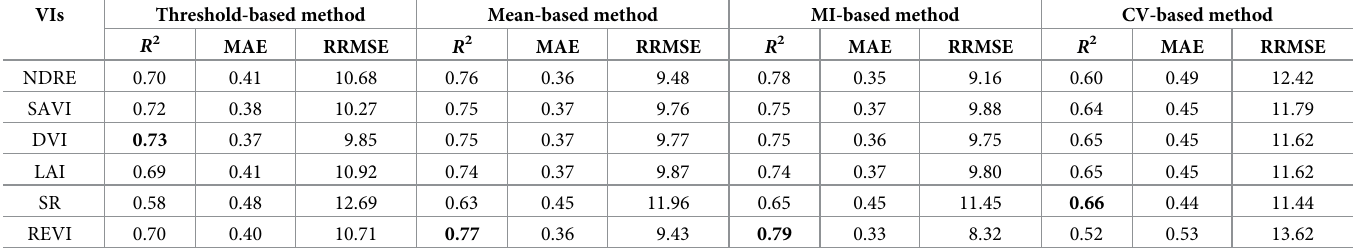
Table 3. The performance comparison of four methods (threshold-based, mean-based, CV-based and MI-based) on six selected vegetation indices for UAV-derived images taken before (DAP-96) manual LLS rating (y). Note that the best thresholds chosen for NDRE (0.50), SAVI (0.7) and DVI (0.45), LAI (3.0), SR (25.0), REVI (0.22) for the threshold-based method (Ref. to Fig 7). VIs Threshold-based method